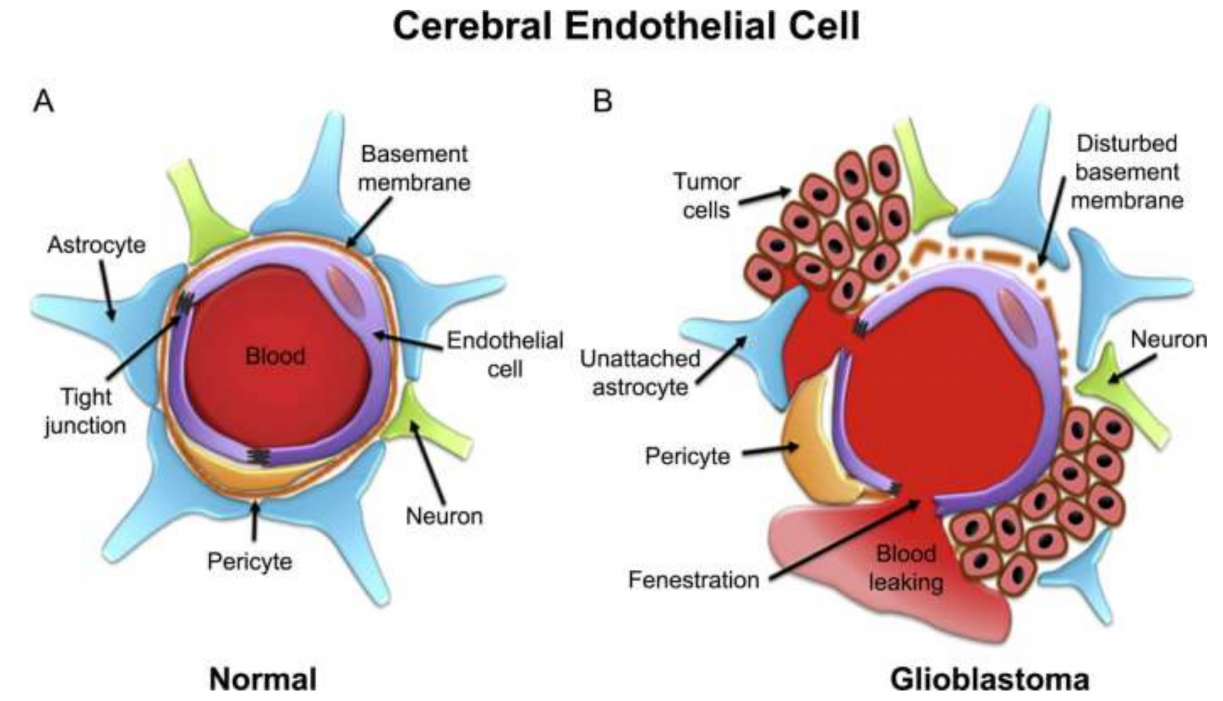
Figure 3. Schematic representation of cerebral capillary showing endothelial cell in ( A ) normal and ( B ) glioblastoma. Reprinted with permission from Ref. [32], Copyright 2020,